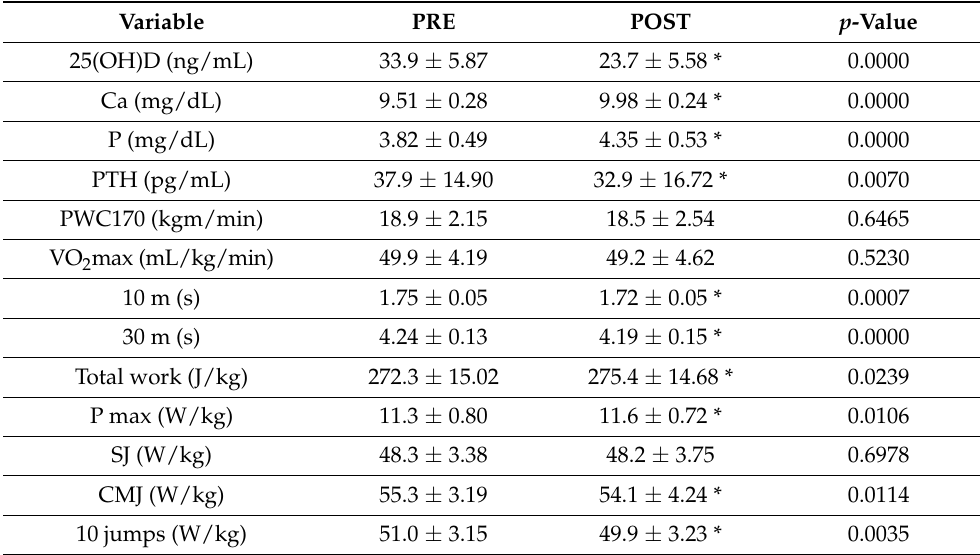
Table 2. Changes in selected blood biochemical and physical performance indicators in the whole group (TG) of footballers ( n = 35) before (PRE) and after (POST) testing